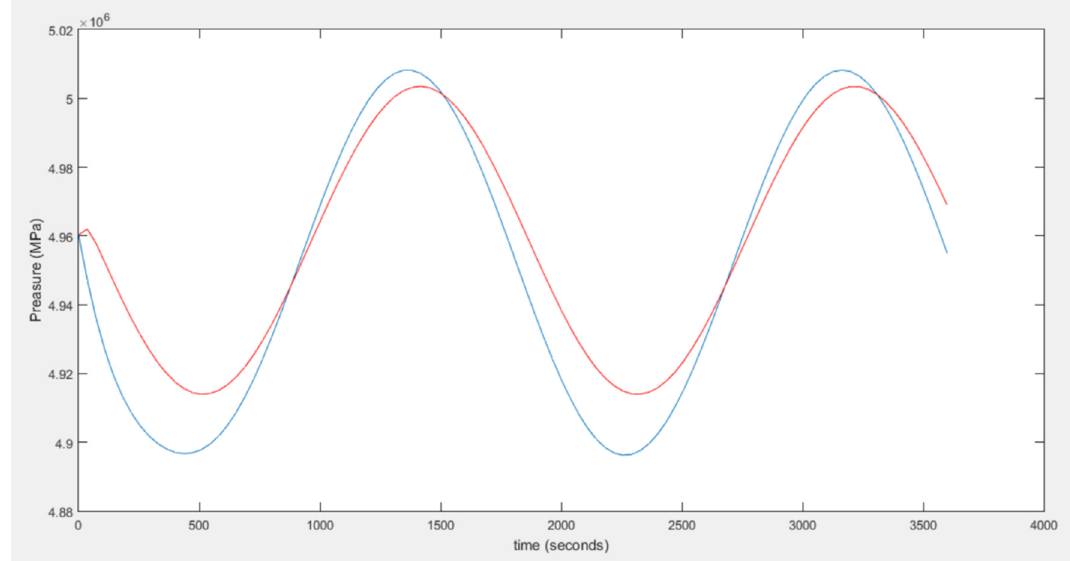
Figure 11. Length = 50 km, diameter = 1.0 m, mass flow = 120 kg/s .